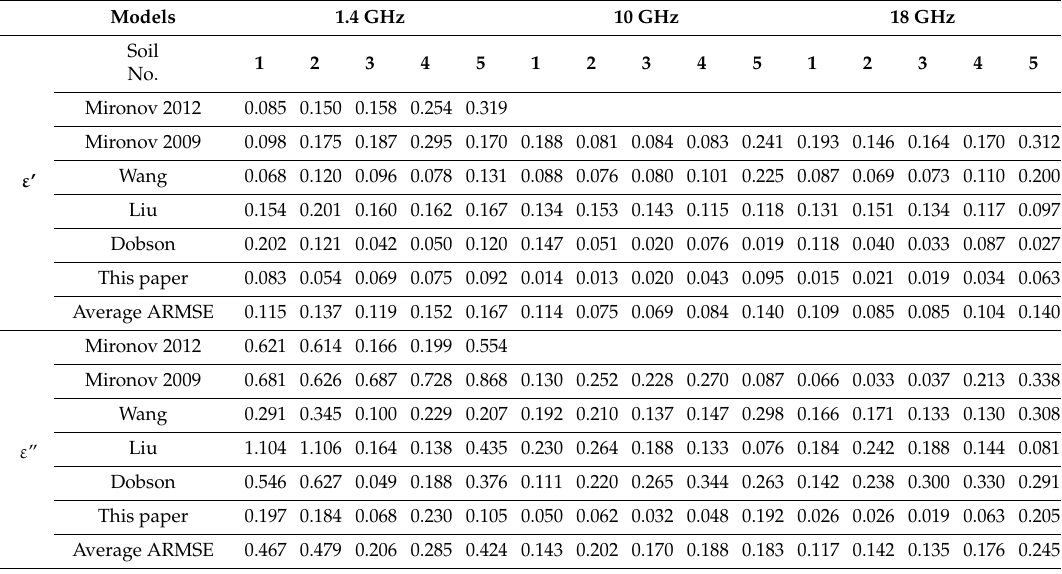
Table 3. ARMSEs of experimental values and calculated values. The bold of Soil No. 1–5 represents five types of in Table